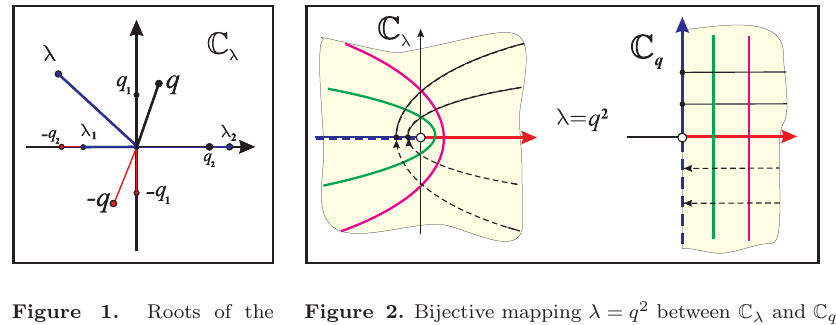
Figure 1. Roots of the Figure 2. Bijective mapping λ = q 2 between C λ and C q equation q 2 = λ .